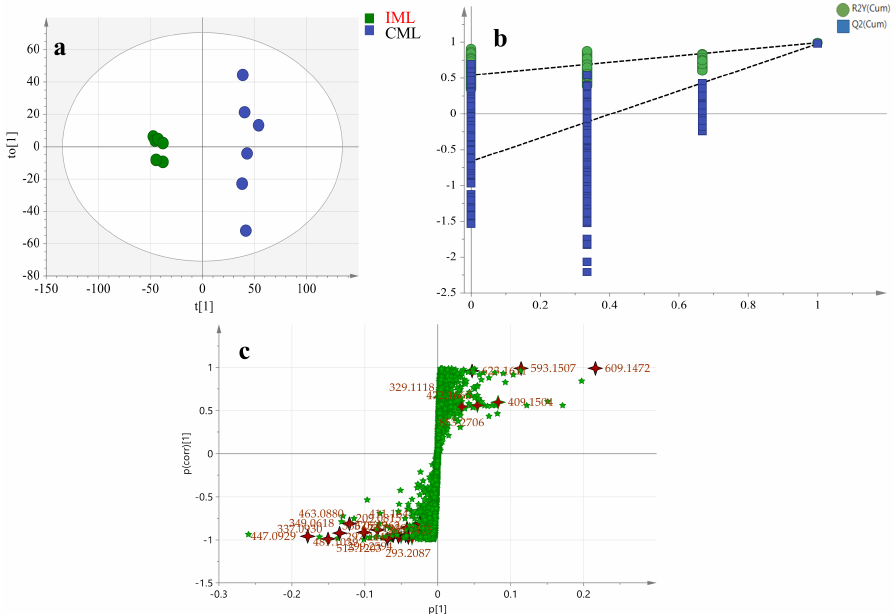
Figure 4. Orthogonal partial least squares discriminant analysis (OPLS-DA) ( a ), permutation tests, ( b ) and S-plot ( c ) in ESI −